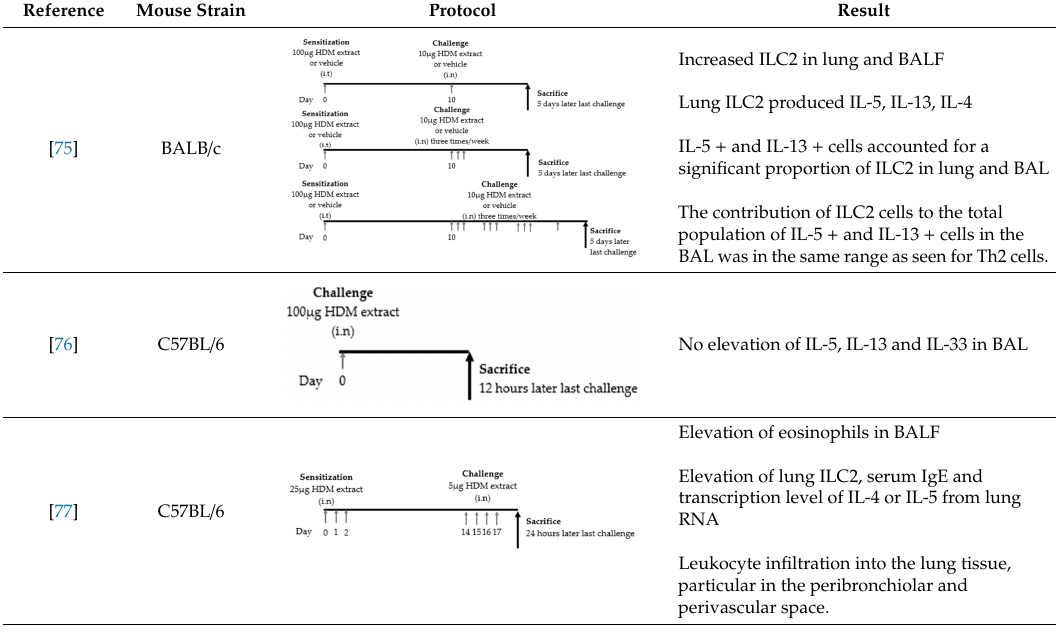
Table 1. Experimental protocols of house dust mite-induced murine asthma models.